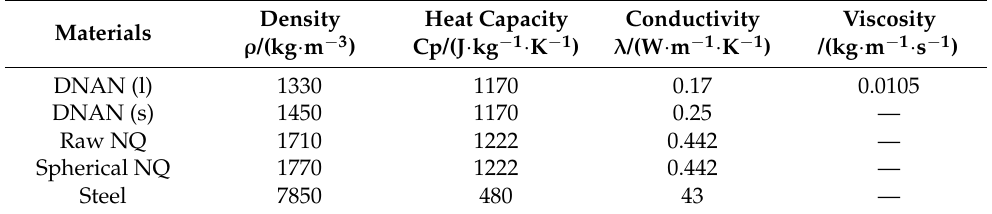
Table 1. Physical parameters of the materials used in the calculations [23].